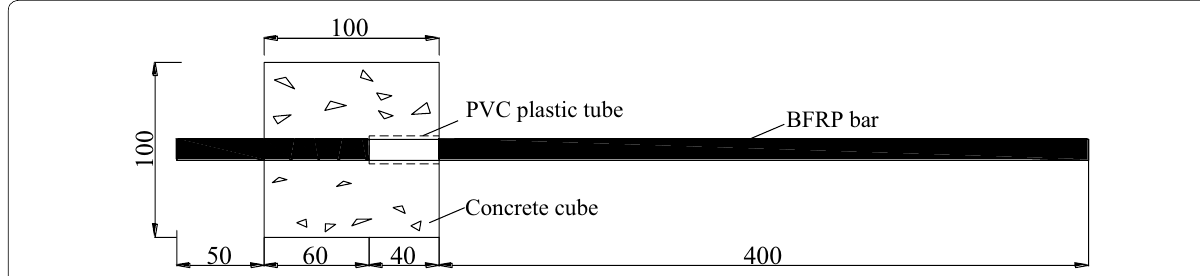
Fig. 1 Specimen for monotonic test and cyclic test.